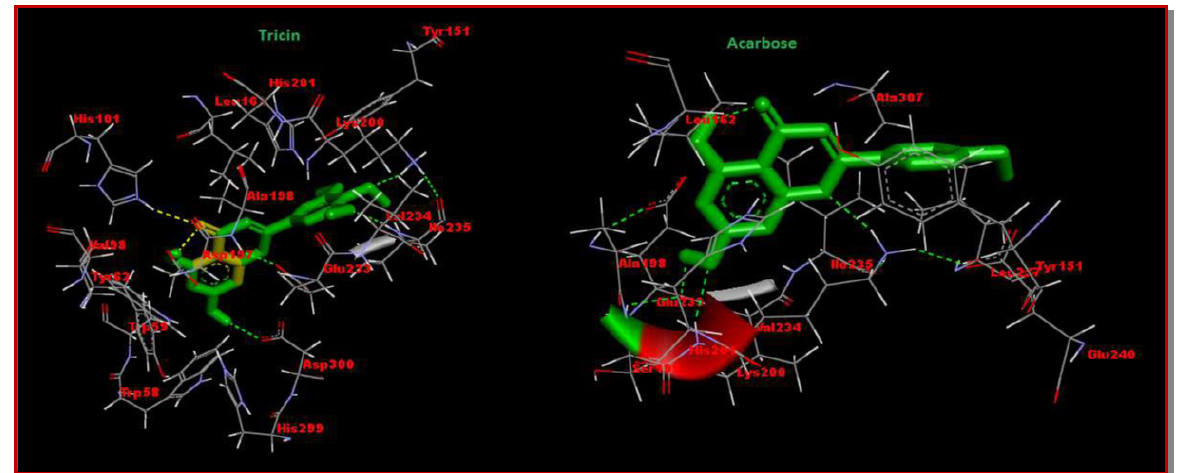
Figure 2: The optimized ligand molecules ( 1 biochanin, 2 chrysin, 3 hesperitin, 4 morin, 5 tricin, 6 vitexycarpin, and 7 acarbose)